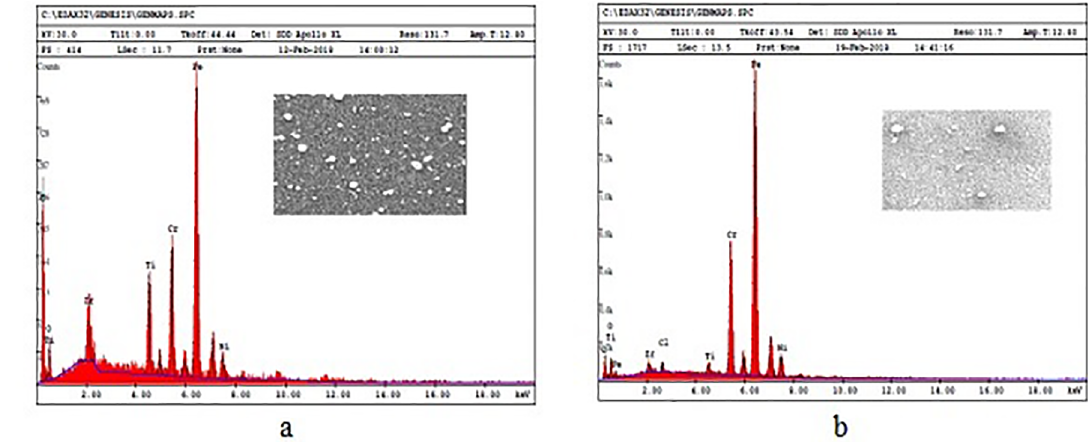
-ZrO coating with a mix ratio of 2 2